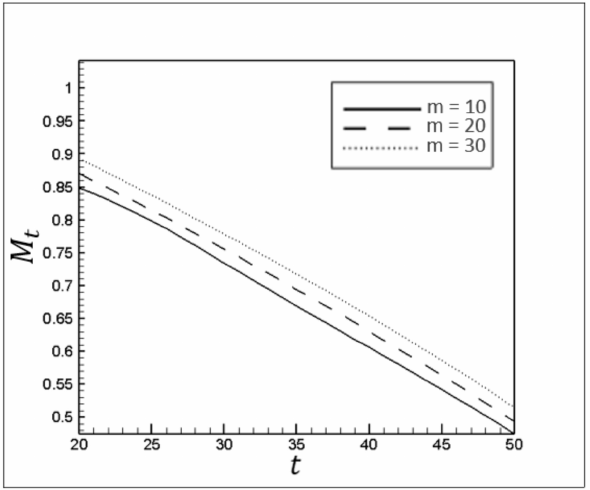
Figure 22. Displacement efficiency over time for different m.